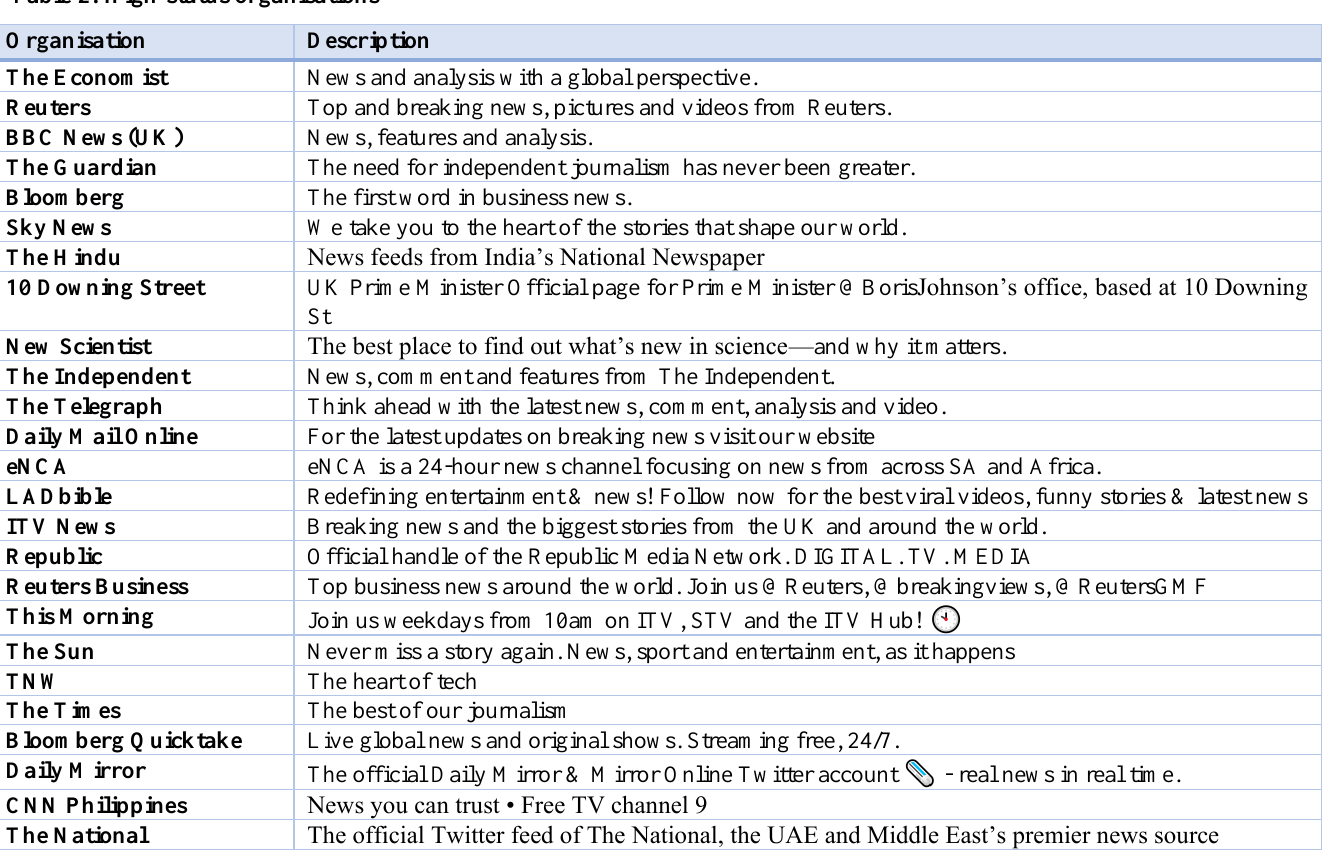
Table 2: High-status